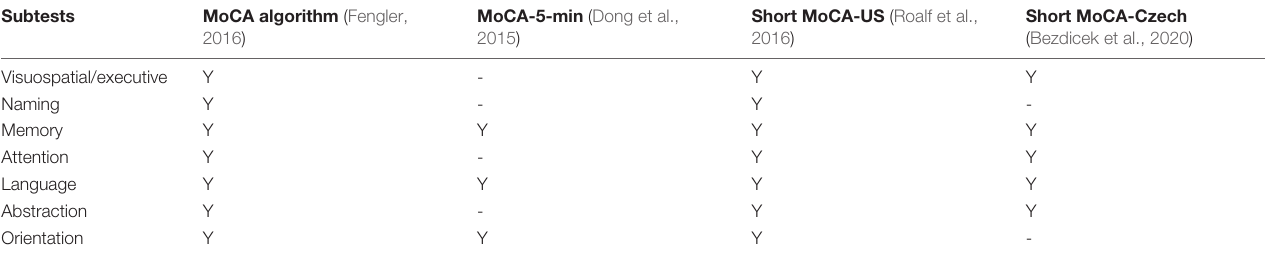
TABLE 2 | Summarize the content of the MoCA algorithm and three short versions of MoCA.